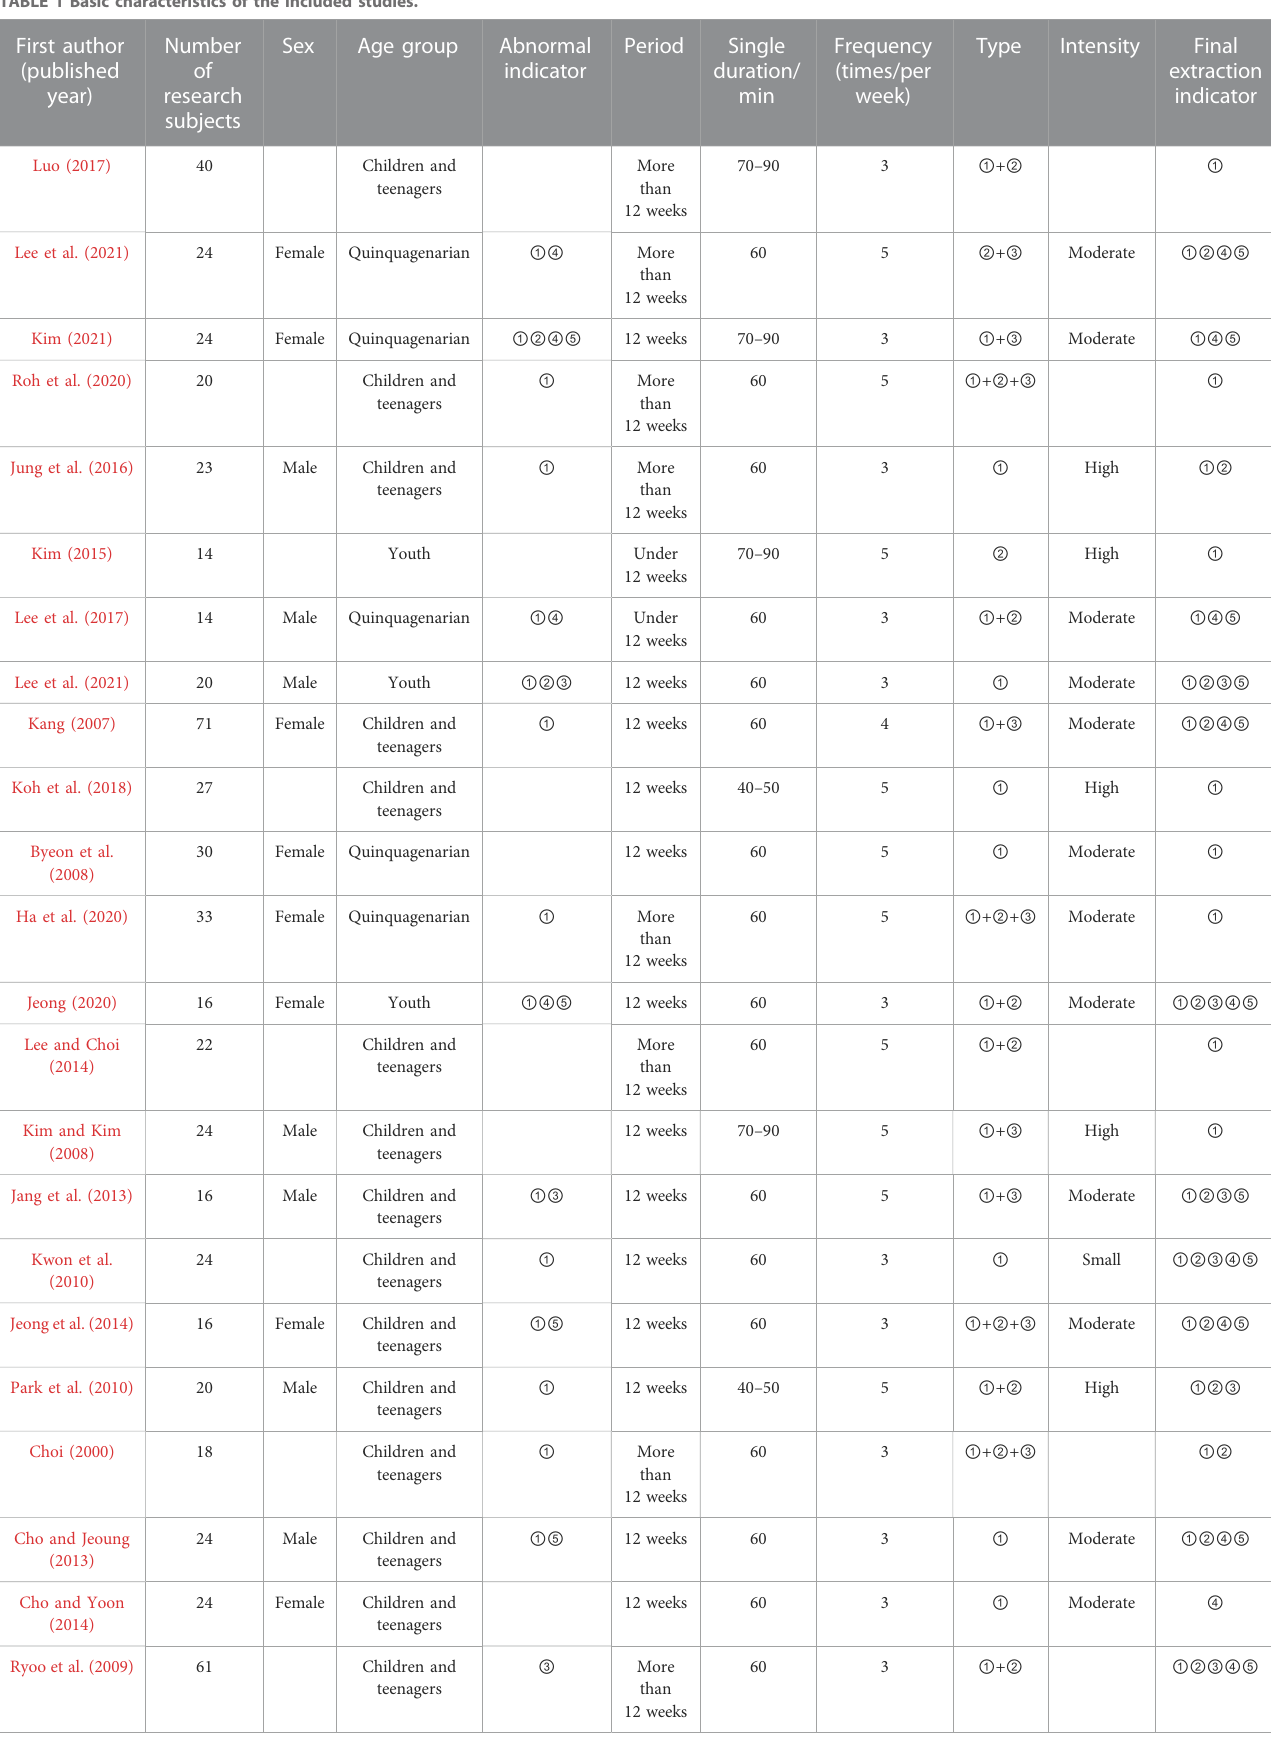
TABLE 1 Basic characteristics of the included